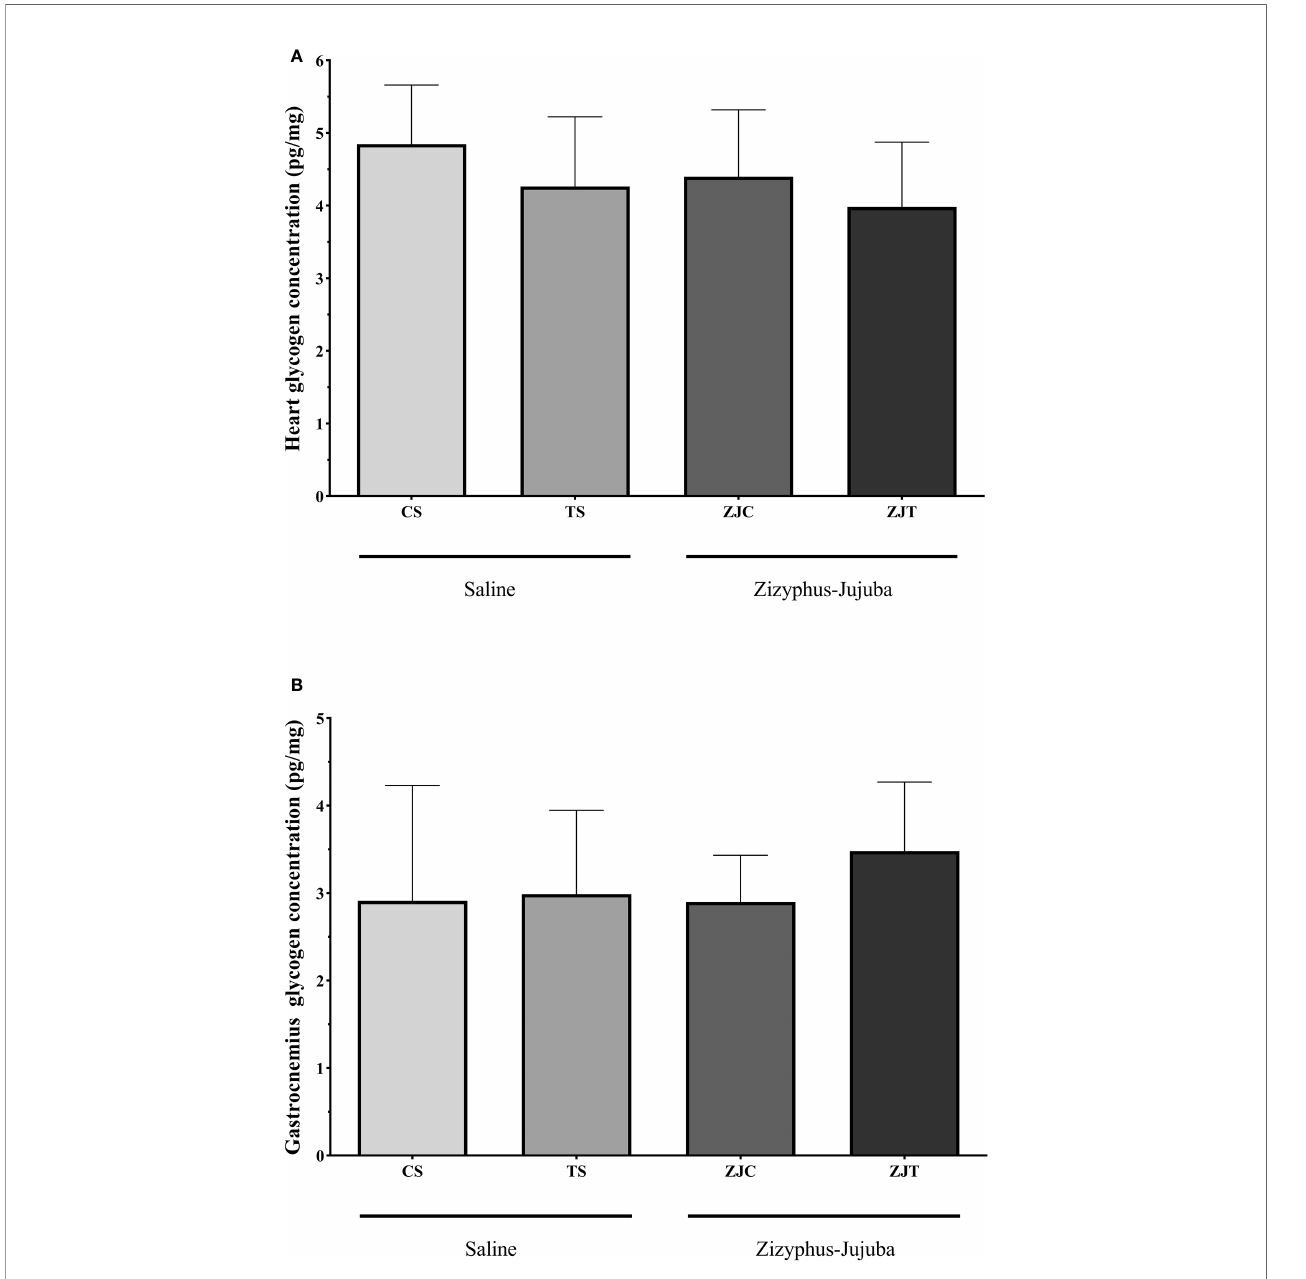
FIGURE 5 | Heart (A) and gastrocnemius (B) muscles glycogen concentrations (Pg/mg) in Saline-Control (SC), Saline-High Intensity Training (ST), Ziziphus jujuba - Control (ZJC), and Ziziphus jujuba -High Intensity Training (ZJT) groups. Data were expressed mean ± SD, P value set at < 0.05, and 7 rats per each Aerobictrainingshowedasigni fi cantdecreaseinplasmacortisol = 0.161, NCP=4.117 and OPW=0.495, Figure 6D ) P =0.05, h 2 p concentration ( F 1,24 = 11.852, P =0.002, h p 2 = 0.331, NCP=11.852 concentration. ZJ supplementation led to a signi fi cant increase in plasmaHDLconcentration( F 1,24 = 16.903, P =0.001and h 2 and OPW=0.911). ZJ use showed a signi fi cant decrease in plasma =0.413, p cortisol concentration ( F 1,24 = 9.439, P =0.005 and h 2 p = 0.282, NCP=19.903 and OPW=0.976). Plasma HDL concentration was higher in ZJT than ST ( P =0.001) ( Figure 6C ). NCP=1.264 and OPW=0.190). Plasma cortisol concentration was Aerobic training had no signi fi cant effect on plasma LDL lower in ZJT than ST ( P =0.007) ( Figure 6B ). ( F 1,24 = 1.475, P =0.236, h 2 p = 0.058, NCP=1.475 and OPW=0.215, Aerobic training led to a signi fi cant increase in plasma HDL h 2 Figure 6E ), TC ( F ( F 1,24 = 19.990, P =0.001, h 2 =0.454,NCP=19.990andOPW=0.990, = 0.029, NCP=0.726 1,24 = 0.726, P =0.403, p p Figure 6C ) and signi fi cant decrease in plasma TG ( F and OPW=0.130, Figure 6F ) and estradiol ( F 1,24 = 2.394, 1,24 = 4.117,